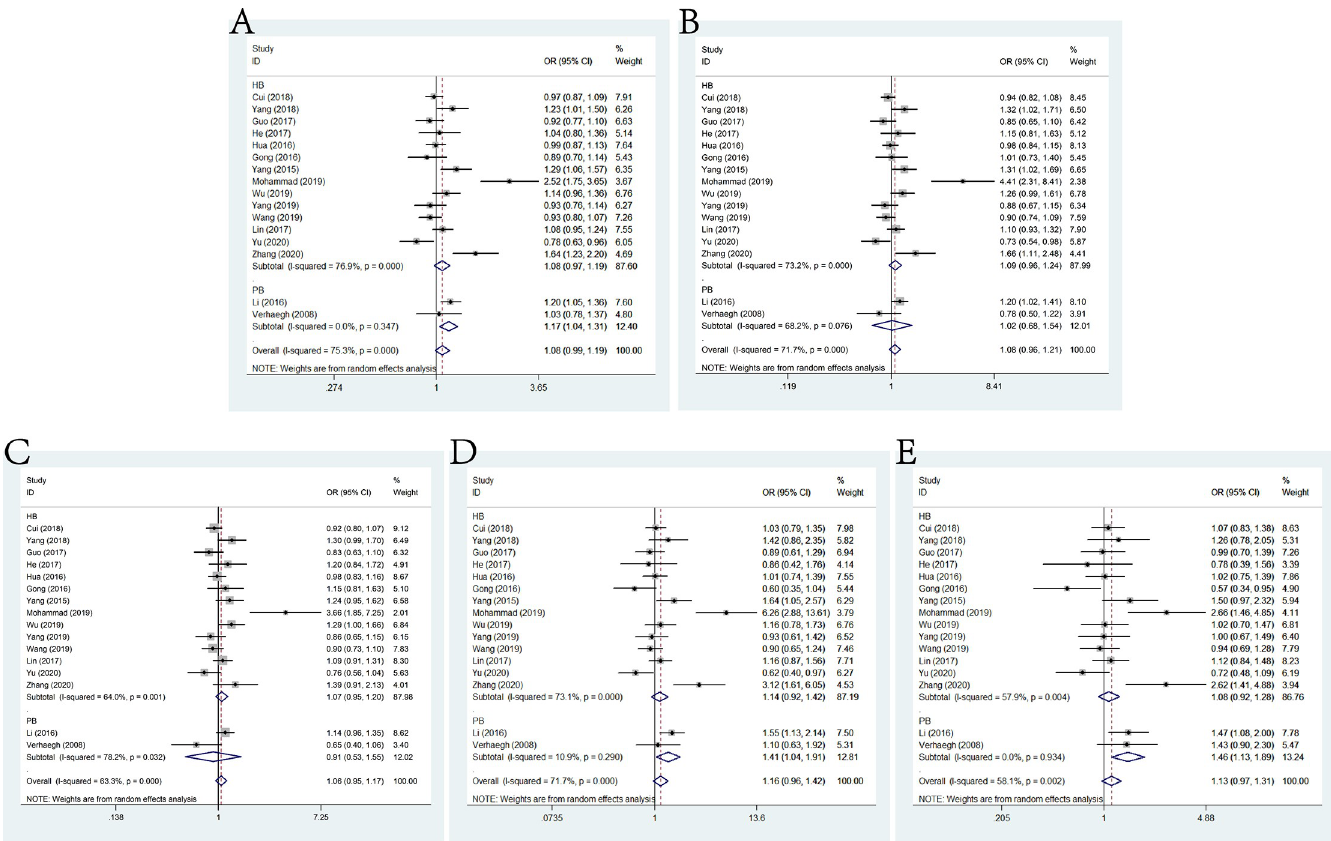
Fig 2. Forest plot of the association between H19 polymorphism rs2839698 G > A and cancer susceptibility. A: allele model; B: dominant model; C: heterozygote model; D: homozygote model; E: recessive model.